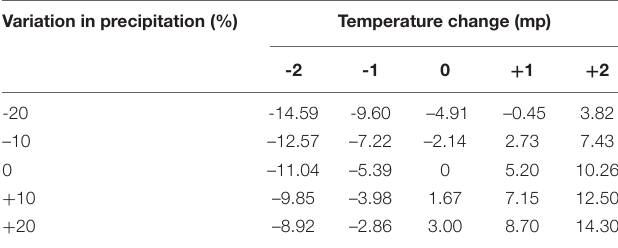
TABLE 2 | Predicted percentage change on pasture productivity based on changes in the annual mean temperature and annual precipitation in the